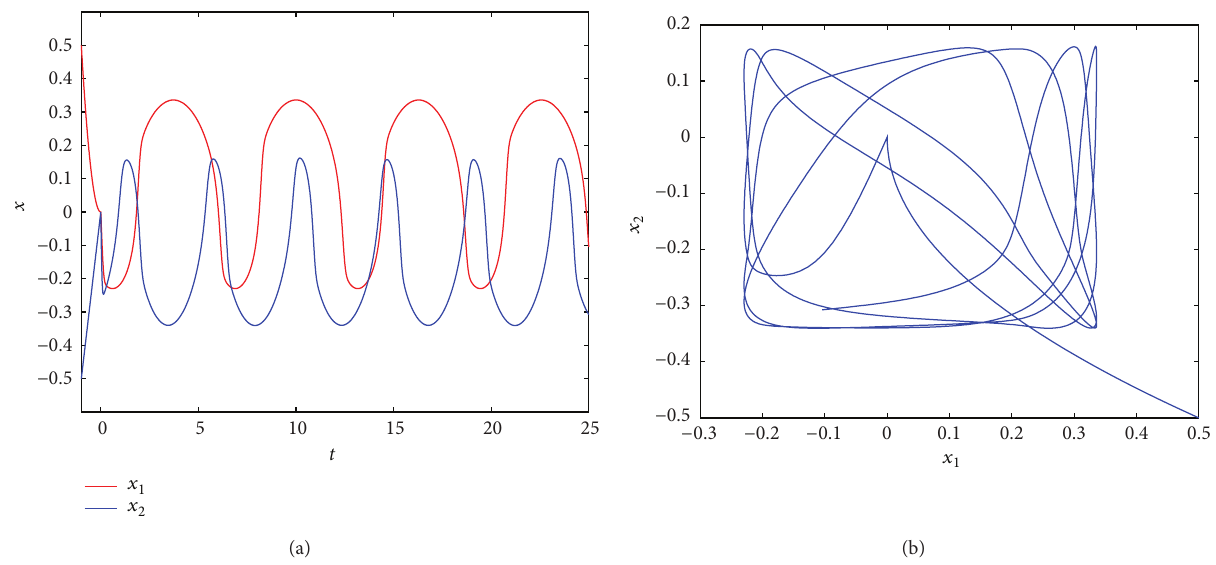
Figure 1: The state trajectory of the network with the initial condition (𝜑 1 (𝑡),𝜑 2 (𝑡)) 𝑇 = (−0.5𝑡 2 , 0.5𝑡) 𝑇 , 𝑡 ∈ [−1,0)